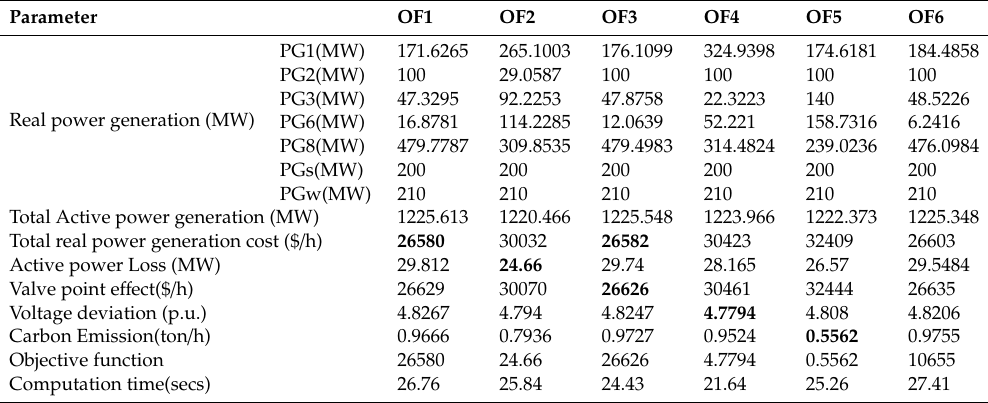
Table 6. Optimal Power flow solution without contingency with TCSC using